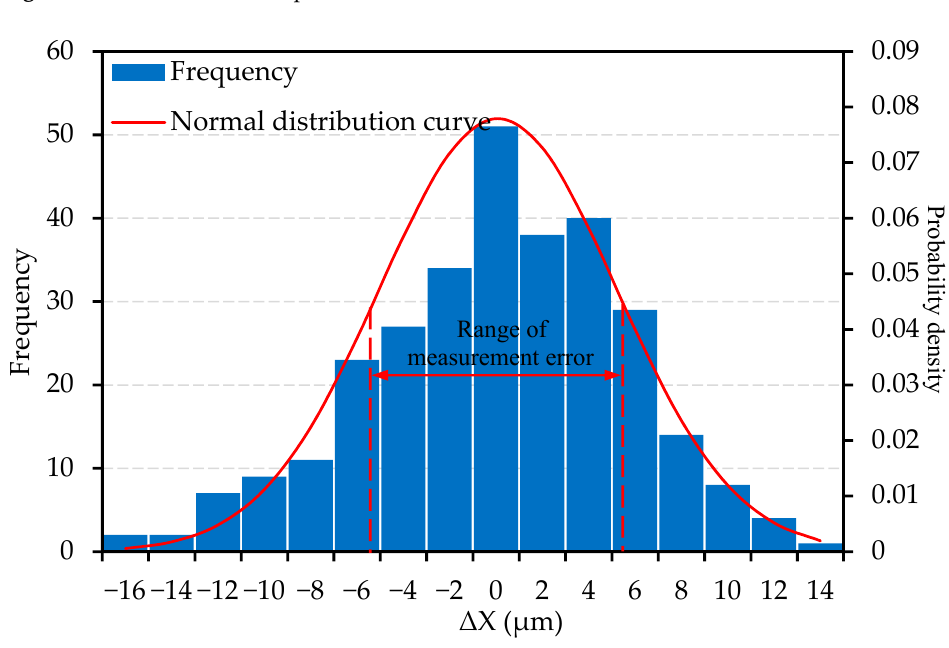
Figure 12. Normal distribution of Δ X.